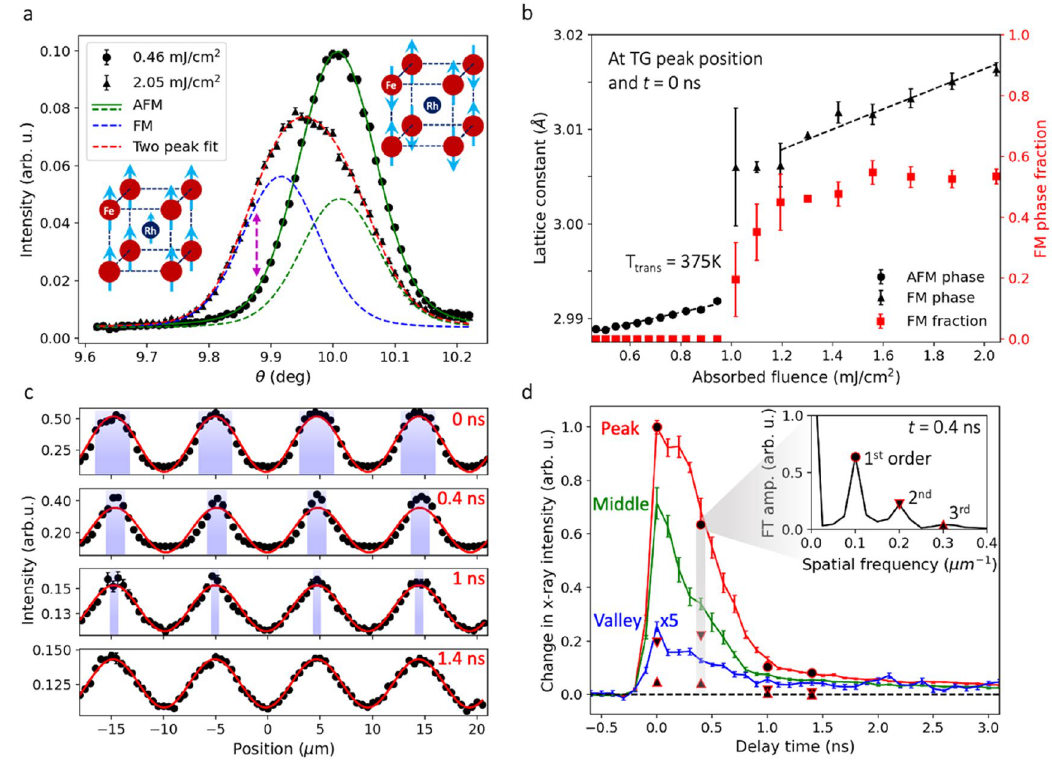
Figure 3. Nonlinear structural dynamics in FeRh. ( a ) 001 Bragg peak measured at the TG peak at t = 0. The peak at low excitation fluences (circles) is in the AFM phase (solid green line fit). At higher fluence (triangles) there is a mixture of AFM and FM phases. Dashed lines fit the contributions of the AFM (green) and FM (blue) phases to the high-fluence curve (red dashed line total). The vertical arrow indicates the value of θ for the measurements shown in ( c,d ). The insets are diagrams of the cubic FeRh lattice showing Fe (red) and Rh (blue) atoms, and the directions of the magnetic moments (arrows). ( b ) Lattice constant and FM phase fraction as a function of absorbed laser fluence. Dotted lines are separate linear fits to the AFM and FM peak centers. ( c ) Diffracted intensity as a function of TG position and delay time with 1.4 mJ/cm 2 peak absorbed fluence. Lines are sinusoidal fits. The shading indicates the approximate locations of regions in which the FM phase occurred. ( d ) Non-exponential decay in X-ray diffraction intensity at various TG positions. The curve for the minimum TG excitation has been multiplied by a factor of 5. The points show the normalized change in the amplitude of the first- (circles), second- (downward pointing triangles), and third- (upward pointing triangles) order Fourier components of the spatial profiles in ( c ). The inset shows the amplitude of the Fourier transform of the TG profile at 0.4 ns. Error bars are described in “Methods”